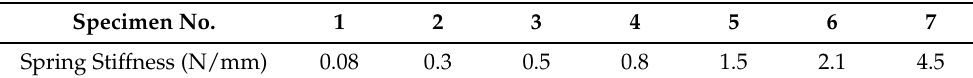
Table 4. The spring stiffness of seven springs.